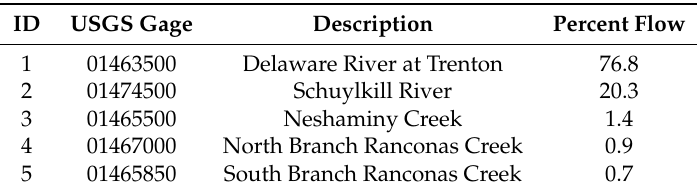
Table 2. Freshwater sources and associated USGS gauges.